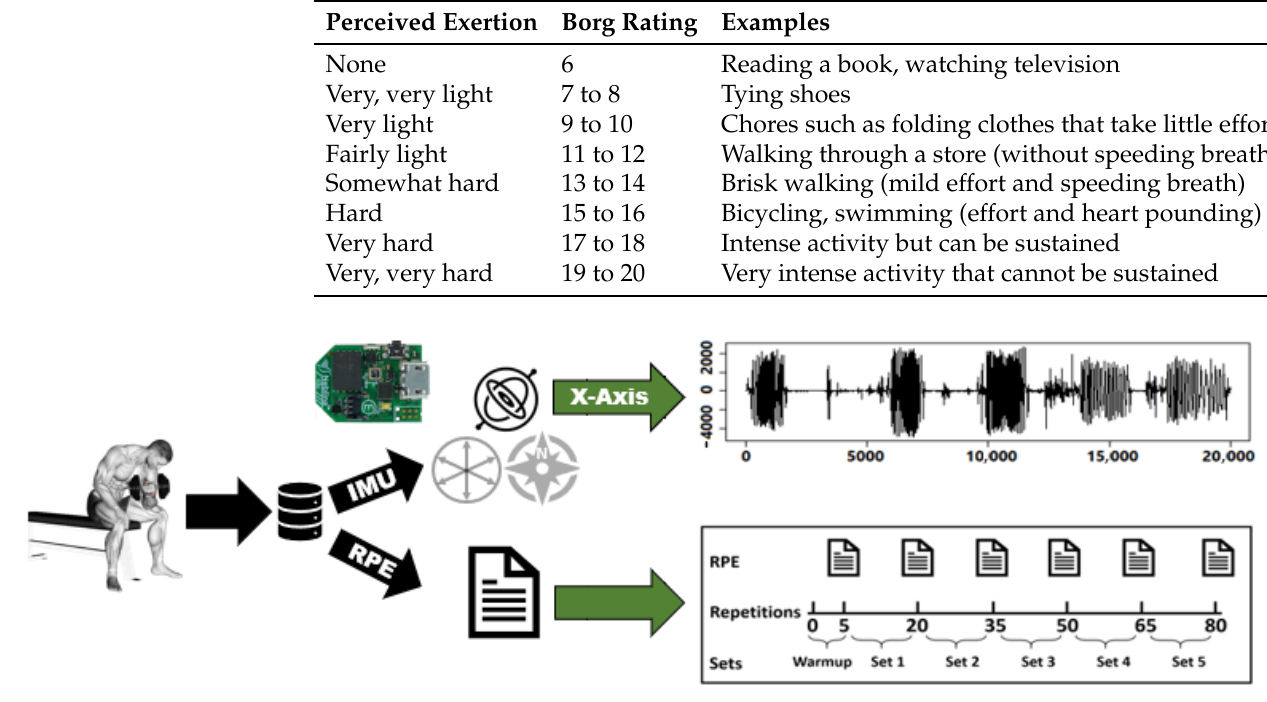
Figure 2. Visualization of data acquisition sessions of biceps concentration curl exercise. Rating of perceived exertion